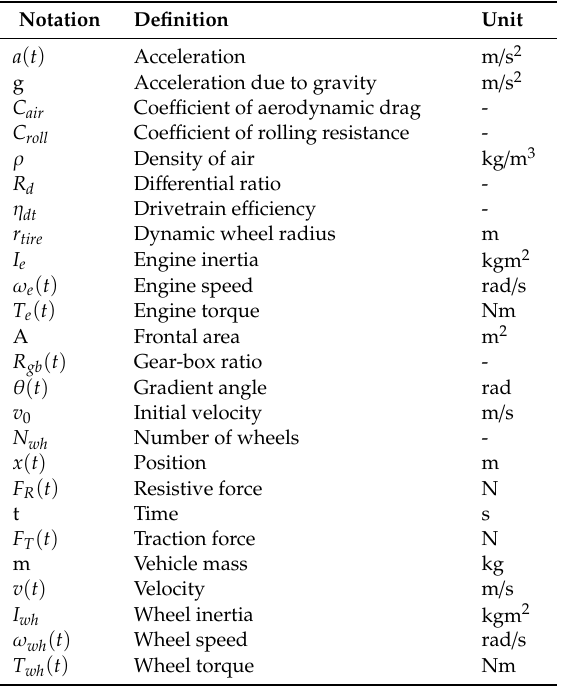
Table 2. Definitions of notations used in vehicle